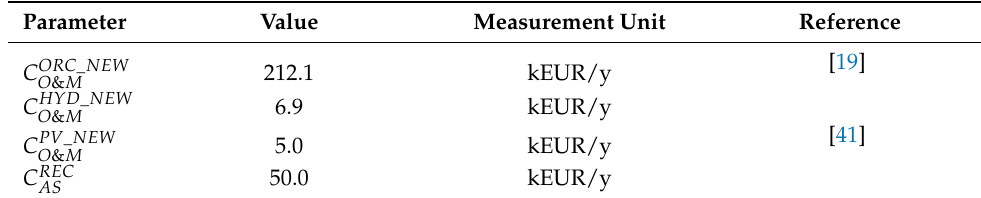
Table 11. Annual operation and maintenance, technical, and administrative staff costs.